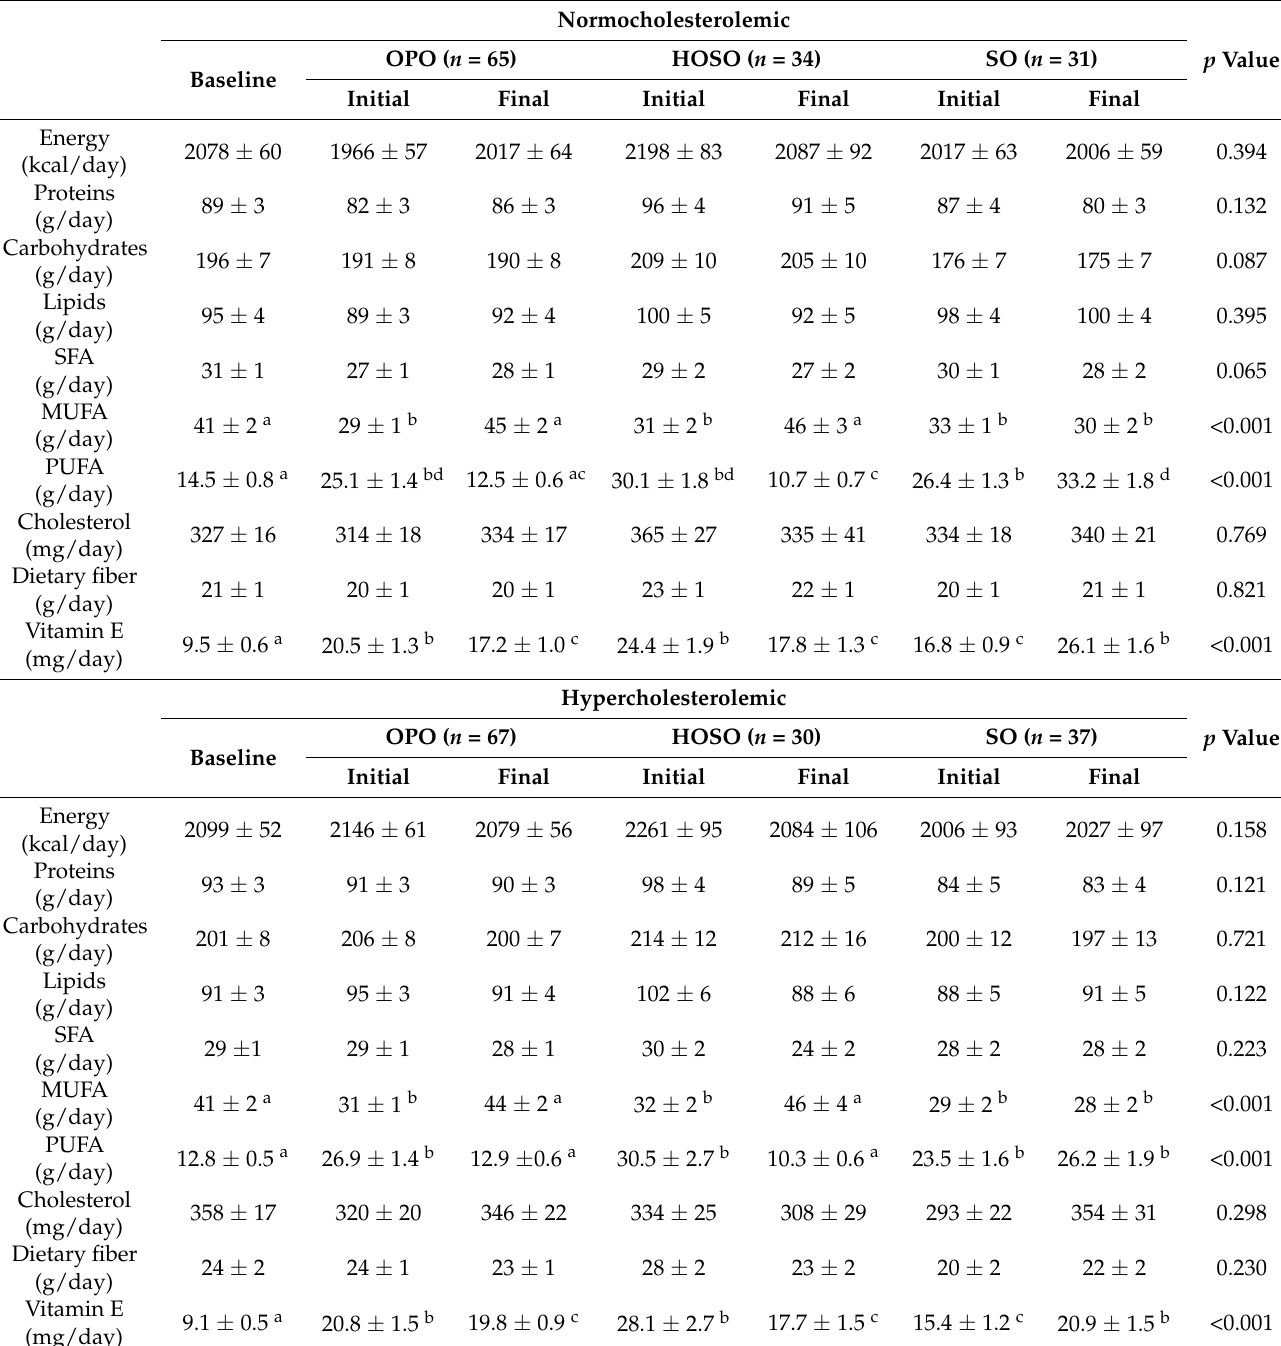
Table 2. Energy intake and dietary